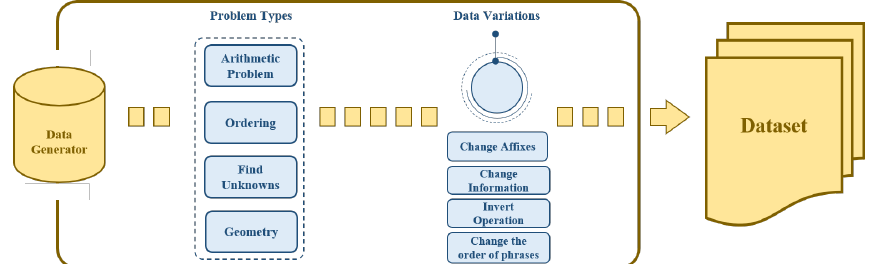
Figure 1. Outline of data generator.